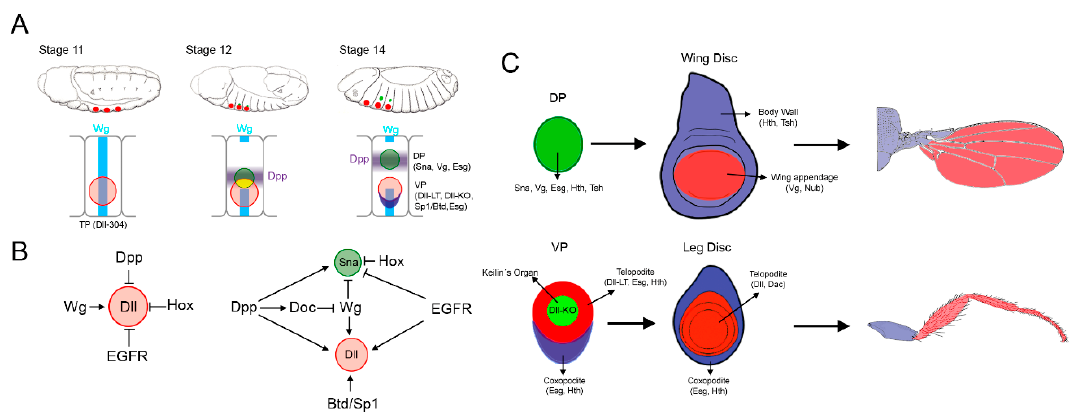
Figure 1. Specification of the thoracic appendages. ( A ) Cartoon showing three representative stages of Drosophila embryogenesis and the sequential appearance of the thoracic primordia (TP, red circle), the ventral primordia (VP, red circle) and the dorsal primordia (DP, green circle). Below is presented a schematic representation of the second thoracic segment where the expression of TP-, DP-, and VP-specific genes is related to the Wg and Dpp signaling pathways. Note that the DP originates from two populations of cells: one within the TP (drawn in yellow) and another one dorsal to the TP; ( B ) Genetic inputs that control appendage specification when Dll is first activated (stage 10–11) and during activation of the DP gene sna (stage 12 onwards). ( C ) Schematic representation of the DP and VP and the imaginal discs and adult structures that they will give rise to (wing and leg, respectively). The subdivision of the wing and leg imaginal discs in the body wall and appendage territories is also shown.